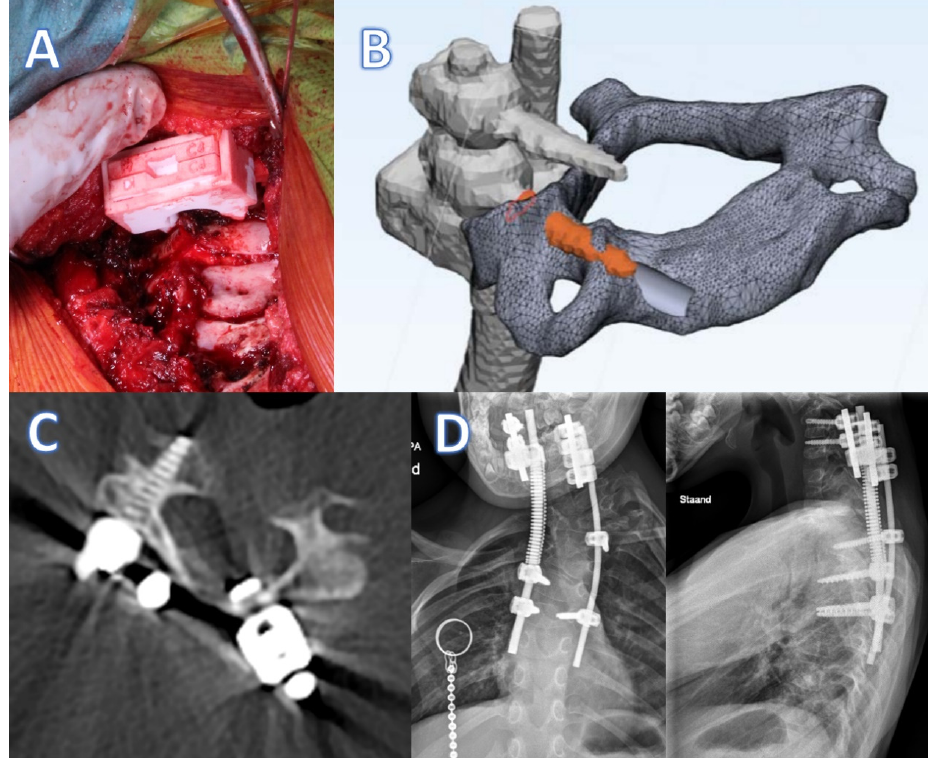
Figure 5. Click-on guide case 1. ( A ) Intraoperative use of the click-on guide, exposure of the operative site limited due to interference with the posterior skull. ( B ) Slight upward deviation of the C6 screw (orange) in comparison to the planned trajectory (gray). ( C ) Post-operative axial CT reconstruction with the screw precisely through the pedicle. ( D ) Post-operative radiographs of the instrumented spine.